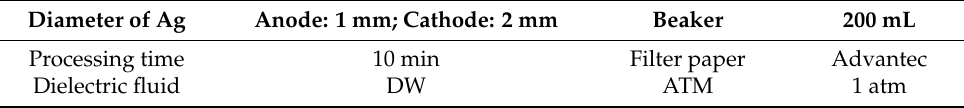
Table 3. Materials and testing conditions of the micro-EDM.